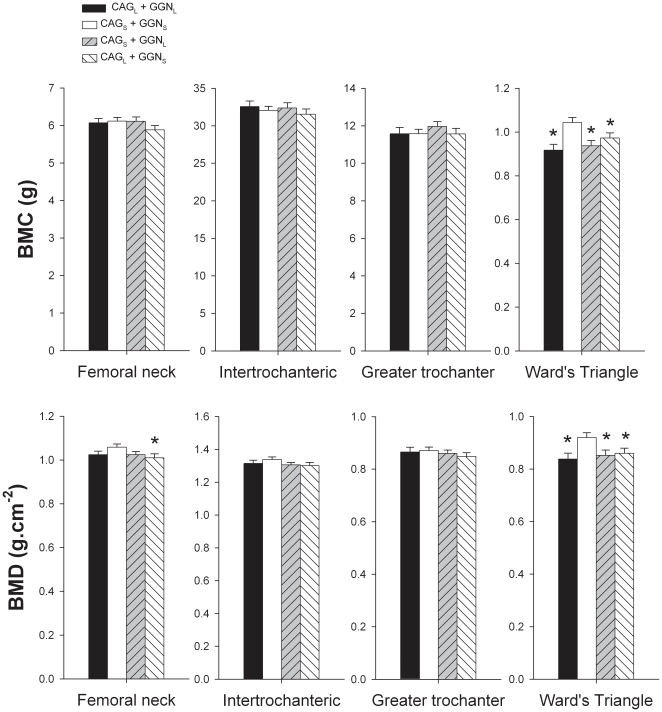
Hip bone mineral content (BMC) and bone mineral areal density (BMD).Subjects were grouped as CAG short (CAGs) if harboring repeat lengths of ≤21 and CAG long (CAGL) if harboring repeat lengths of >21. The cutoff point for GGN short (GGNs) was GGN repeat polymorphism ≤23, otherwise subjects were included in the GGN long (GGNL) group. Four haplotypes combinations were defined as: CAGL + GGNL, CAGS + GGNS, CAGS + GGNL, and CAGL + GGNS. * P<0.05 compared to CAGS + GGNS; § P<0.05 compared to CAGL + GGNS.